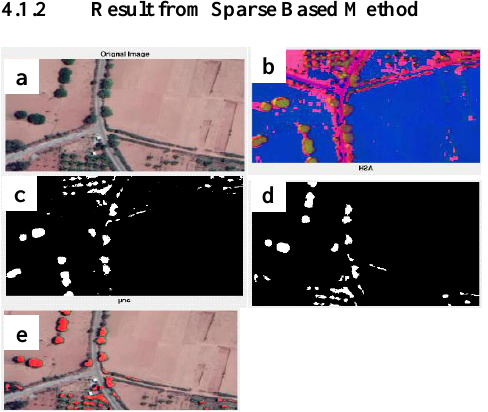
d Figure 8 (a) Inputted image, (b) HSV image, (c) Thresholded image, (d) Refined and filtered image, (e) Trees highlighted with orange color Figure 8a shows the input image on which the processing has to be done and estimation of tree count is to make. Figure 8b shows the HSV image after conversion. After which filtering is done on HSV image, the process begins with removing background pixels. Secondly, the region which can cause ambiguity with trees counting process are filtered out. Figure 8c shows the thresholded image after filtering. Figure 8d shows the image after selecting the region of interest and now, the regional maxima are marked on the image, and the image is then passed for watershed segmentation. The output of which is shown in figure 8e where trees are highlighted with orange color. Figure 9 Output from Sparse Based Detection Method The output is shown in figure 9 with original image and number of trees. The number of trees found in the image is 39. By manual interpretation, there are around 41 trees.